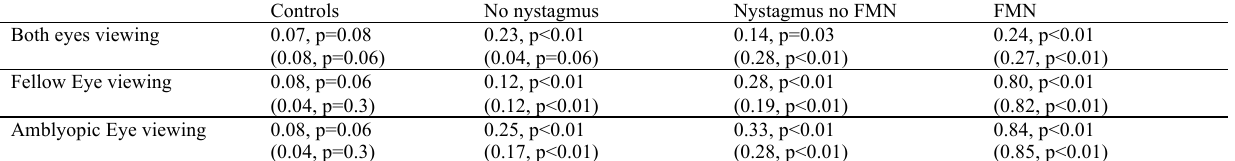
Table 3: Correlation between inter-saccadic drift velocity/slow phase velocity and fixational saccade/quick phase nys- tagmus amplitude respectively by eye movement waveform